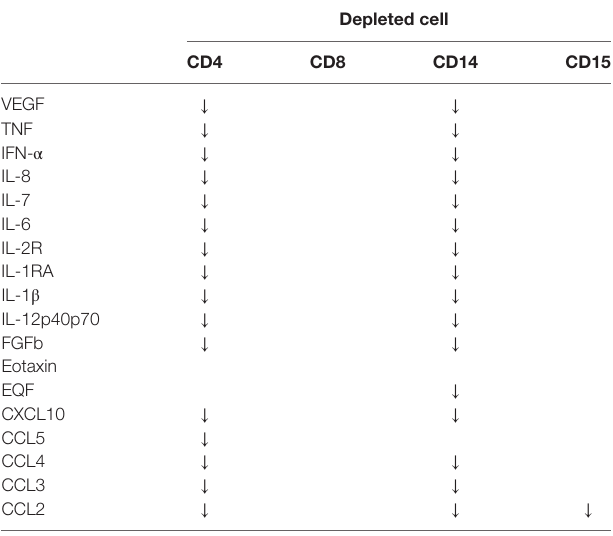
TaBle 1 | Summary of impact of cell depletions on supernatant cytokines and chemokines from Mycobacterium tuberculosis -infected